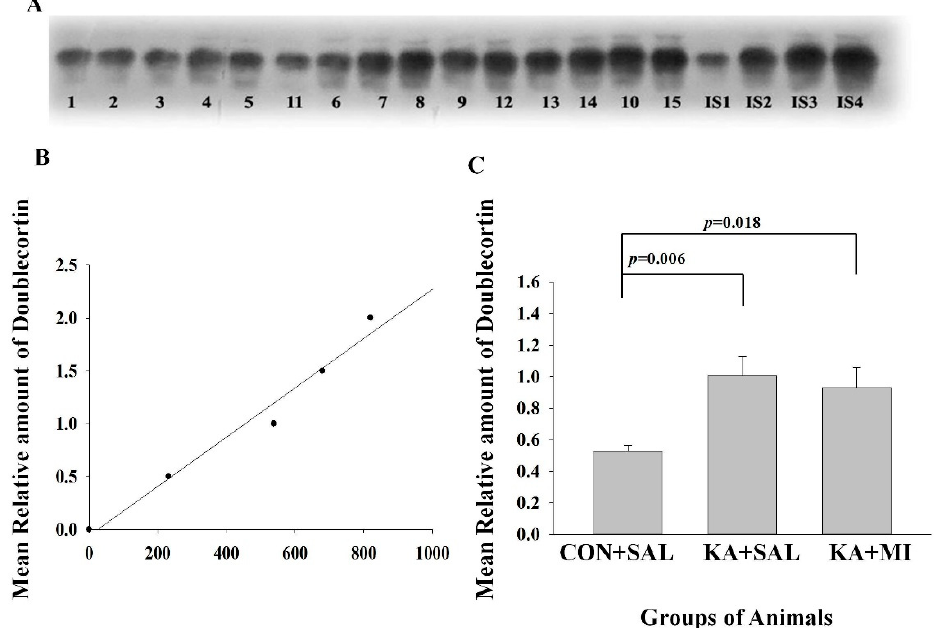
Figure 7. Hippocampus, Doublecortin levels are increased both in KA + SAL and KA + MI groups. ( A ) Sample film, where each lane corresponds to one sample. Lanes 1–5 are from CON + SAL group; lanes 6–10 from KA + SAL group and lanes 11–15 from KA + MI group. Lanes IS-1-IS4 internal standards containing, respectively, 15, 30, 45, and 60 µ g protein. ( B ) Calibration plot (lines fitted by linear least-squares regression); ( C ) Mean levels of Doublecortin (mean ± sem) The details of statistical analysis are provided in the manuscript.